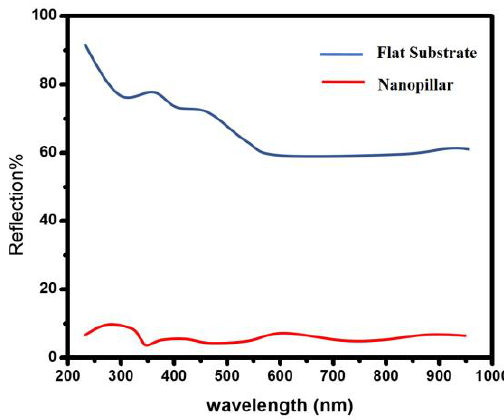
Figure 7. The reflectance spectrum for flat and Si nanopillar substrates.